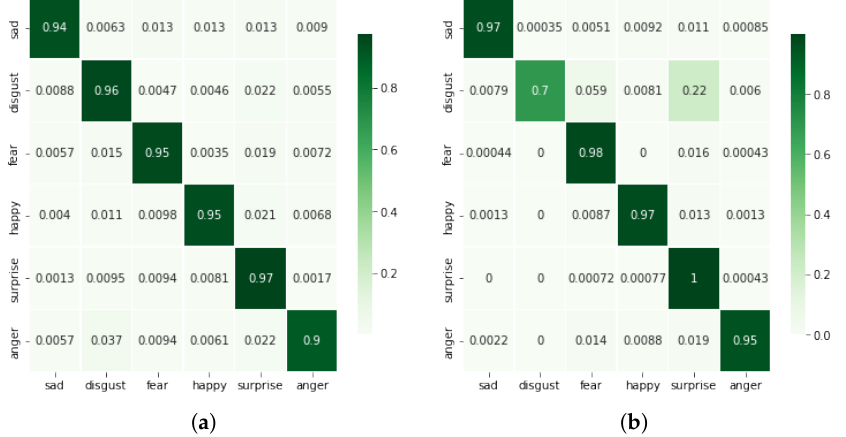
Figure 6. Confusion matrices are computed when the proposed model is fed with 3D accelerations ( a ) and 3D angular velocities ( b ).